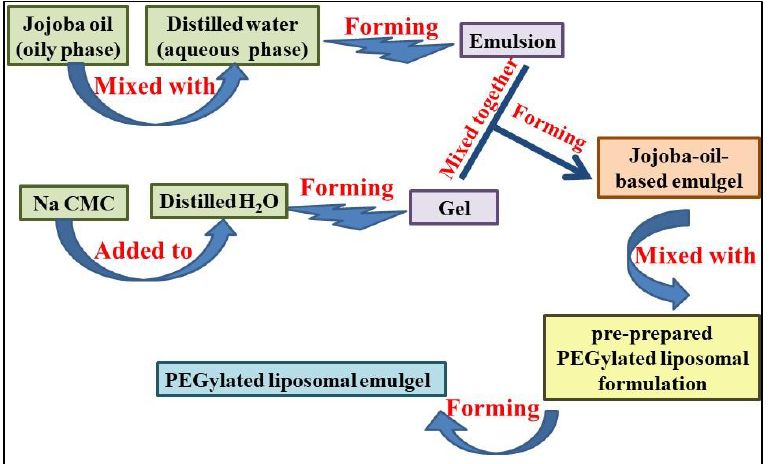
Figure 11. A schematic representation demonstrating the steps of manufacturing PEGylated liposo- mal emulgel incorporating Brucine.